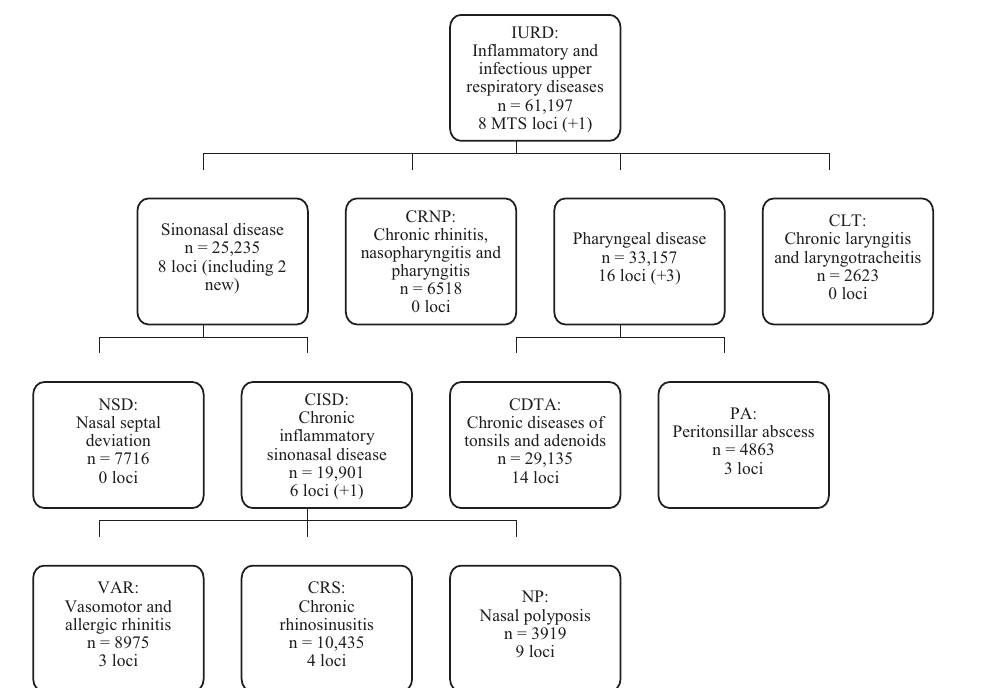
Fig. 2 | The IURD phenotype structure, based on genetic correlation between phenotypes. The boxes represent a GWAS of a IURD phenotype or group, stating thename,casecount,and anumberofMTSloci,indicatinginparenthesistheMTS loci that were not detected in any directly preceding ( “ child ” ) GWAS. E.g., there were two loci in sinonasal disease GWAS that had not been detected in NSD, CISD, VAR,CRS,orNPGWASs.Thehierarchicalstructureshowsthephenotypesincluded